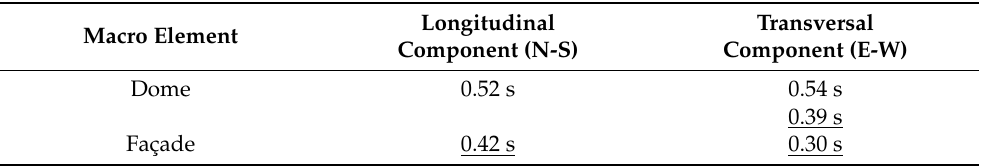
Table 2. Natural periods of the dome and the façade separated according to longitudinal and transversal component. Values inside the maximum spectral acceleration range are underlined.